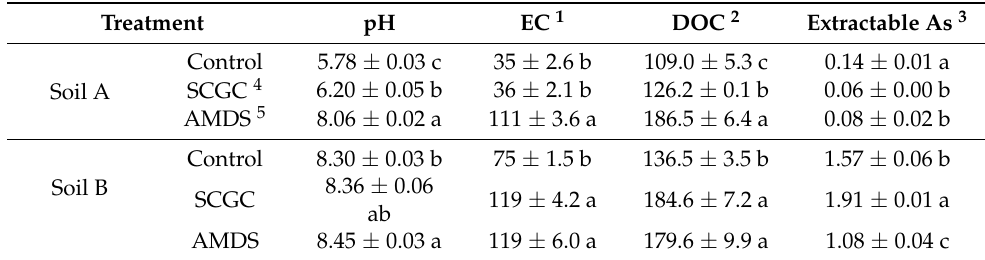
Table 2. Effect of amendments on chemical properties of soils